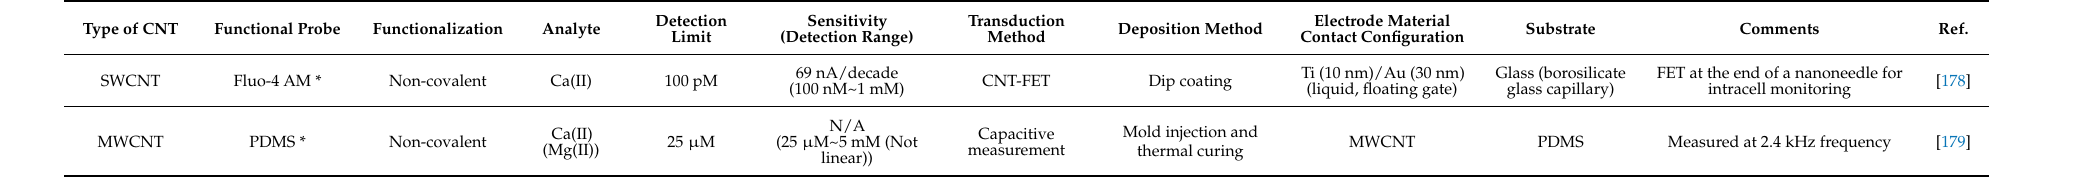
Table 12. CNT-based water hardness sensors in